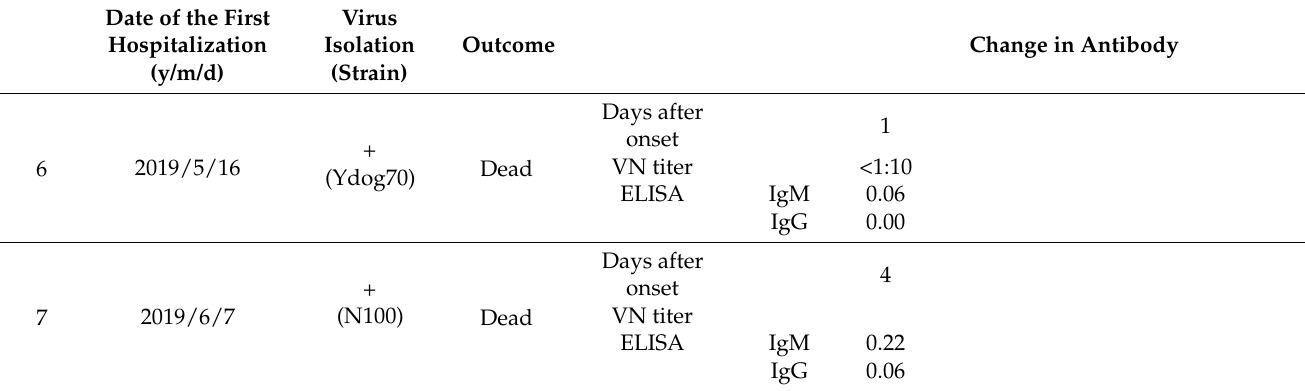
Figure 1. Detection of anti-SFTSV antibodies in dog sera. OD values of the ELISA are plotted. Broken lines indicate the cut-off value. Left figure shows the plot of the OD values of the IgM ELISA, while the right figure shows the plot of the OD values of the IgG ELISA. Dogs were divided into two groups, SFTSV + or -, according to the results of RT-PCR for SFTSV. Open boxes indicate dogs that died due to SFTS infection.